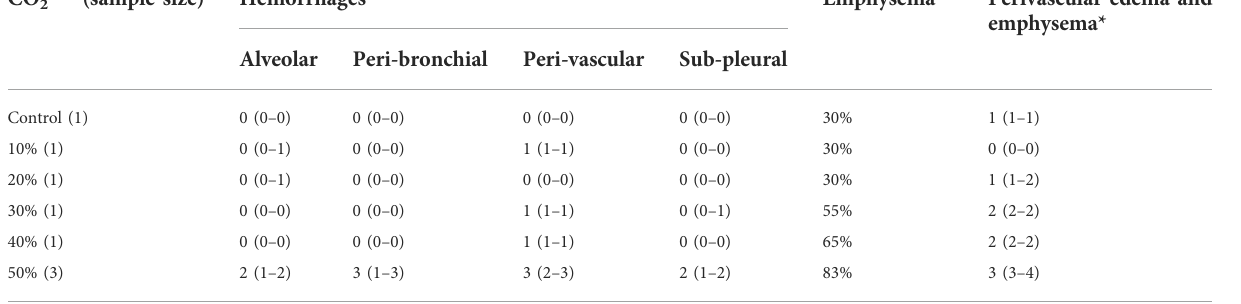
TABLE 2 Effect of CO 2 on lung damage in